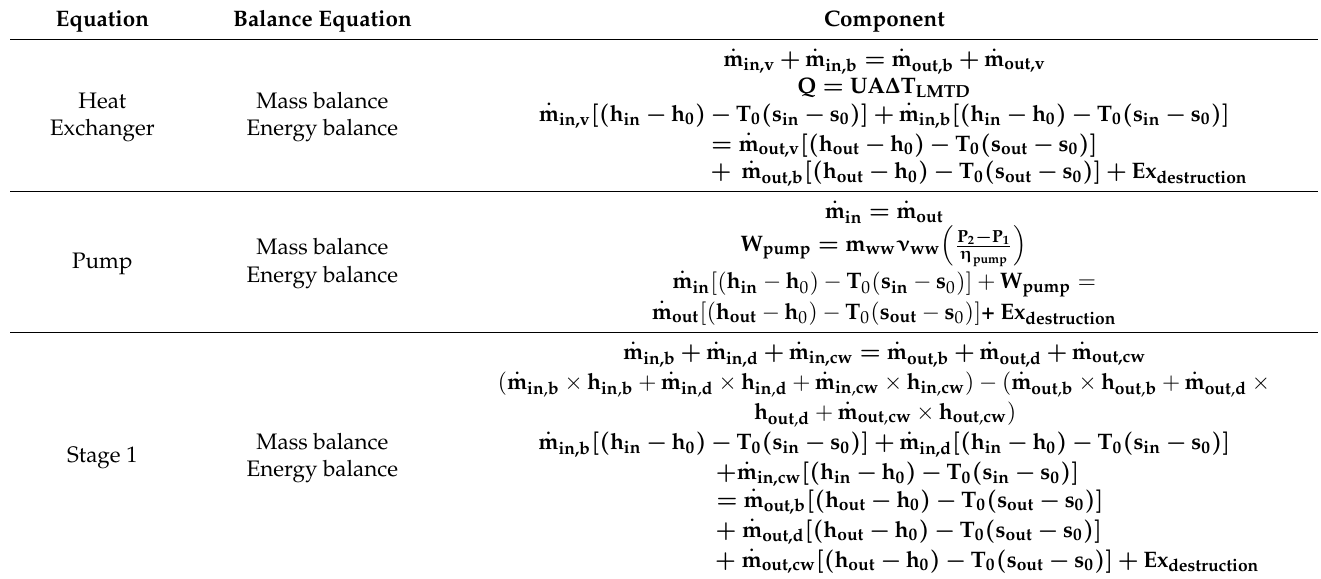
Table 3. Mass, energy and exergy balance equations for desalination system components.